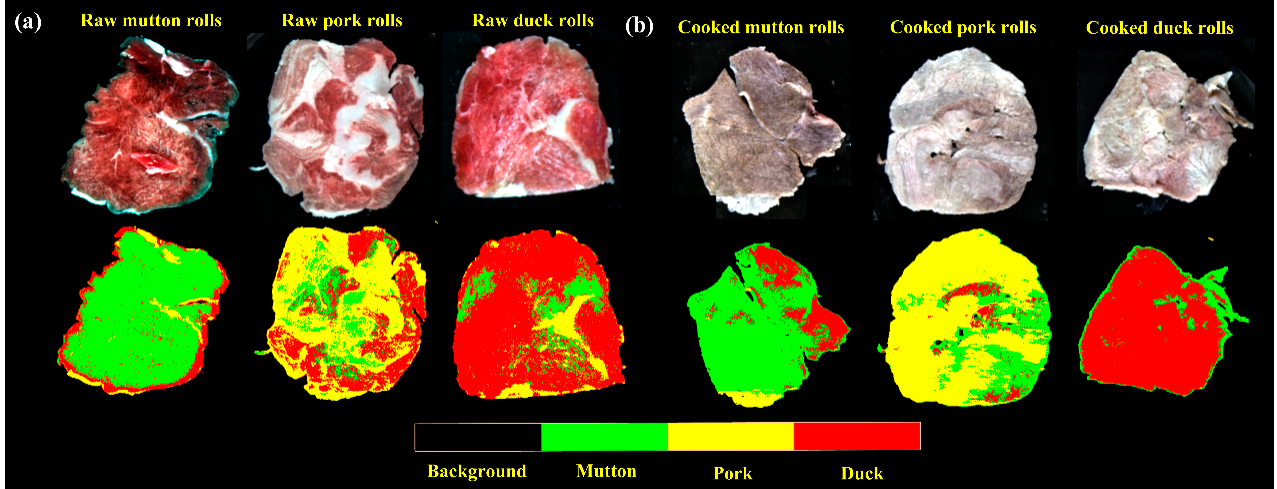
Figure 6. The visualization of classification maps of ( a ) raw and ( b ) cooked meat rolls.